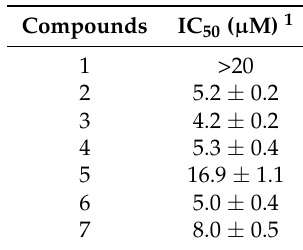
Table 1. The suppressive effect of Compounds 1 – 7 from B. kazinoki on NO production in LPS-activated RAW 264.7 macrophages.